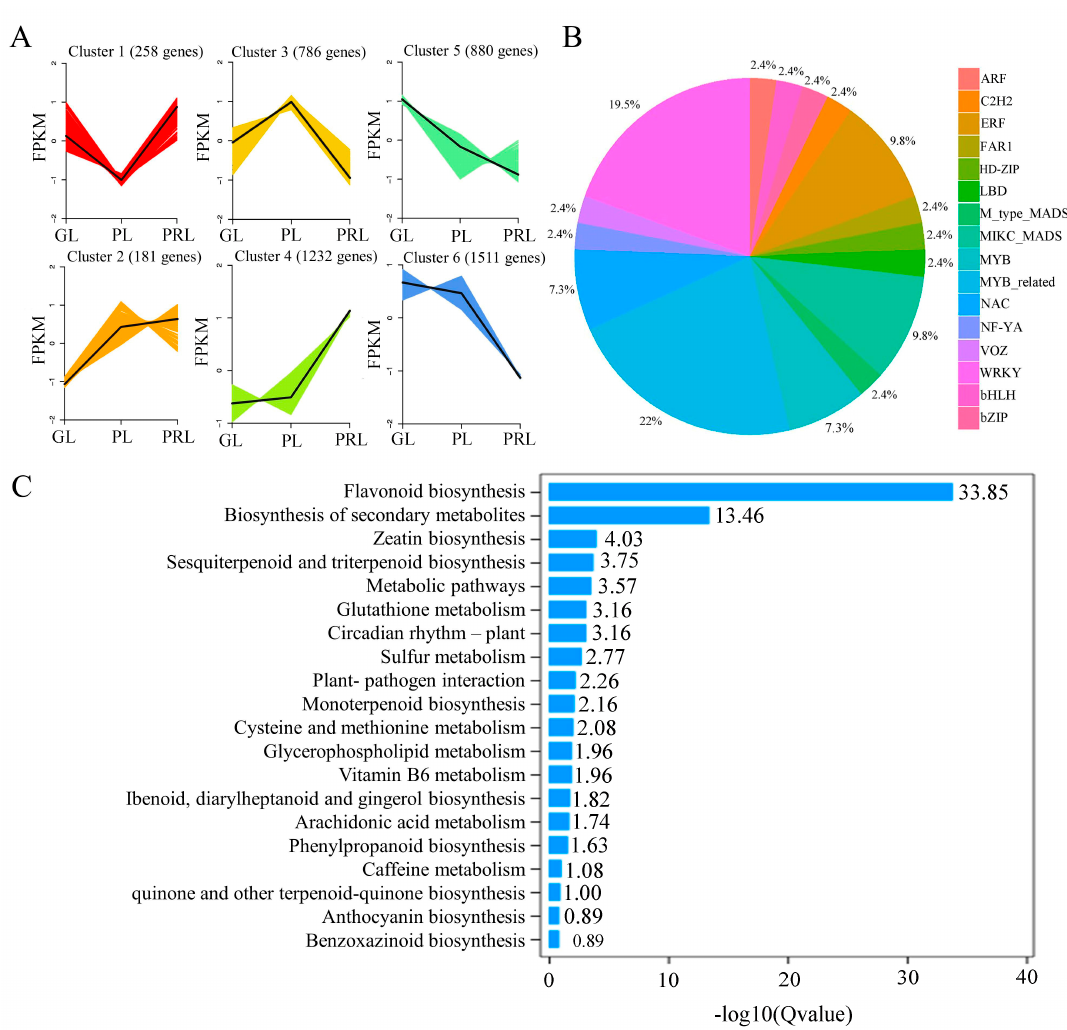
Figure 5. Gene regulation during leaf color change. ( A ) K-means cluster analysis of co-expression genes and their expression patterns. ( B ) The DEGs involved in transcriptome factor enriched in cluster 4. ( C ) KEGG enrichment bar plot of DEGs in cluster 4. Cluster 4 represents the expression pattern of 1232 co-expression genes identified in the K-means cluster analysis. FPKM represents the fragments per kilobase per million.